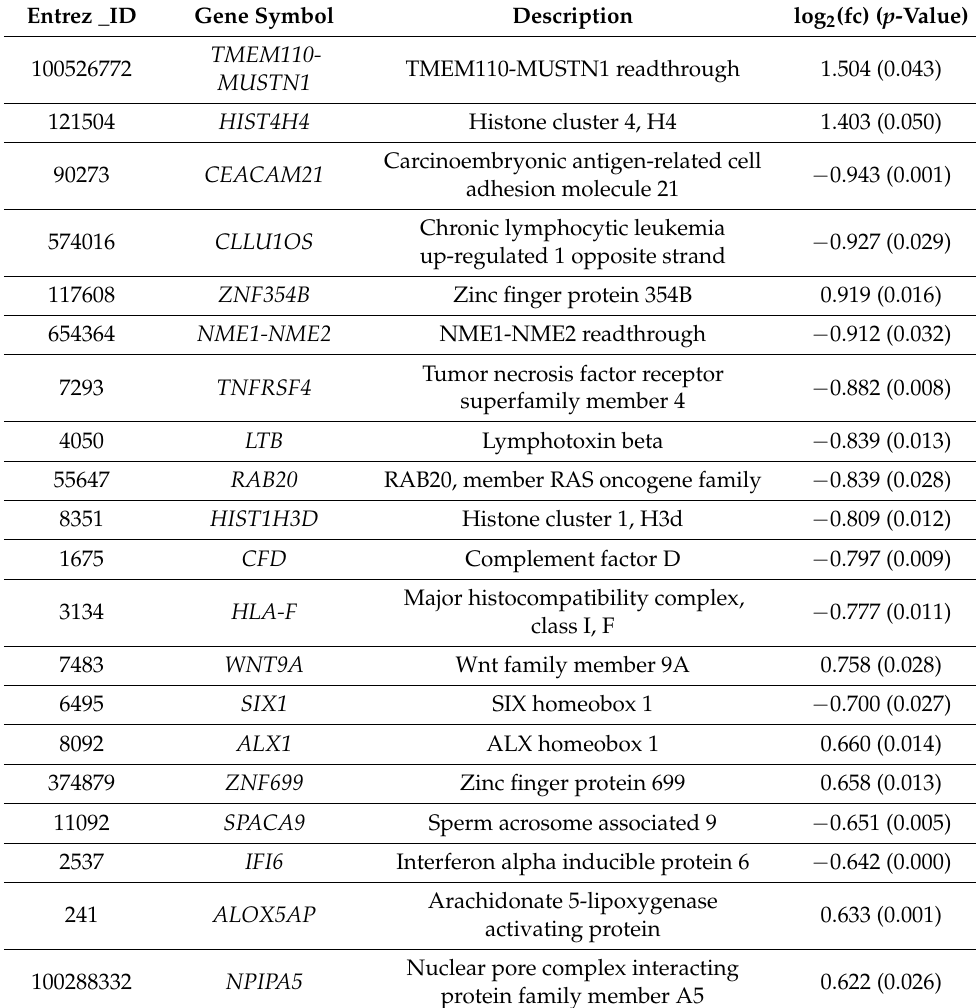
Table 2. List of 20 genes showing the most significantly modulated expression following low-dose radiation in